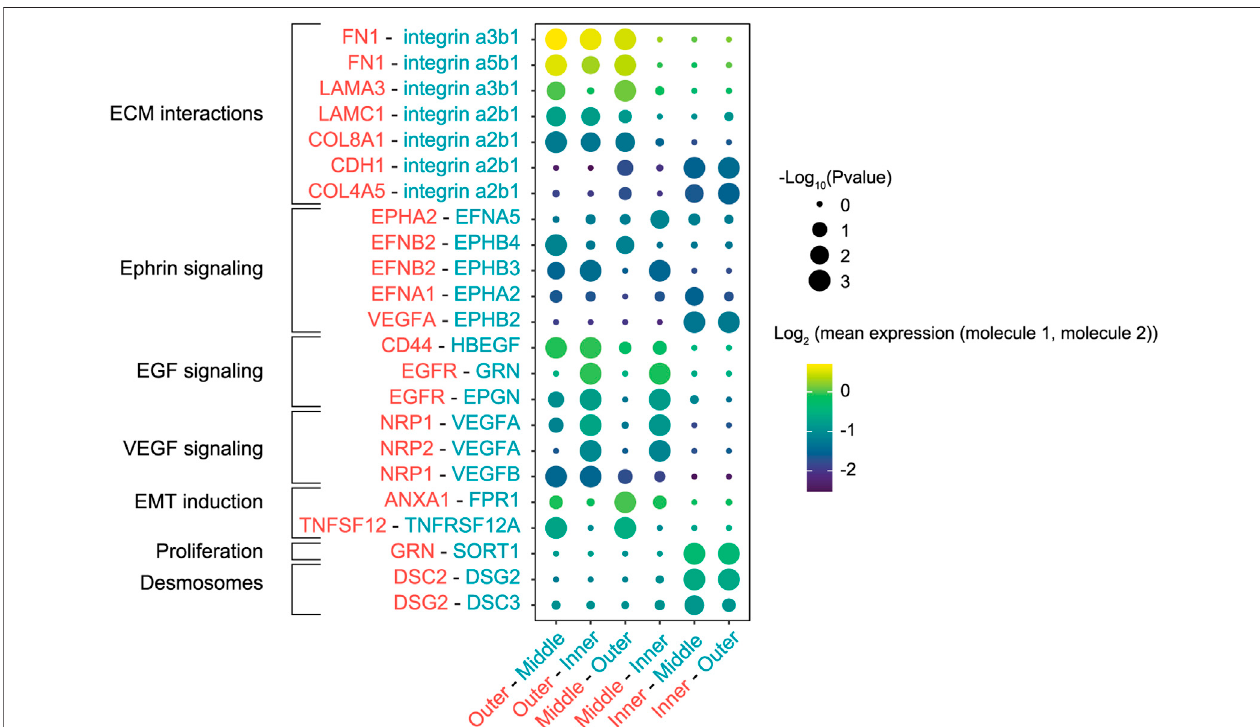
FIGURE 3 | Cell-cell interactions between cells in various patch regions labeled with the smaller bandwidth. Interactions were inferred based on the expression of ligands and receptors in the different cell populations. The fi rst molecule in each interaction pair (rows) corresponds to the fi rst region in each population pair (columns). Circles scaled by the signi fi cance of the interaction and colored by the average expression level of ligand and